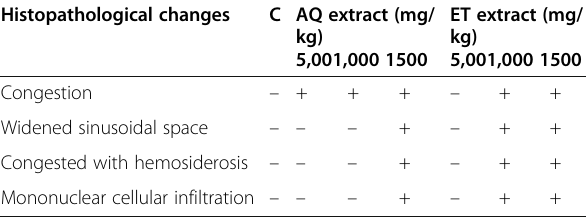
Table 4 Histopathological result of rat ’ s liver administered aqueous and ethanolic extract of Spondias purpurea